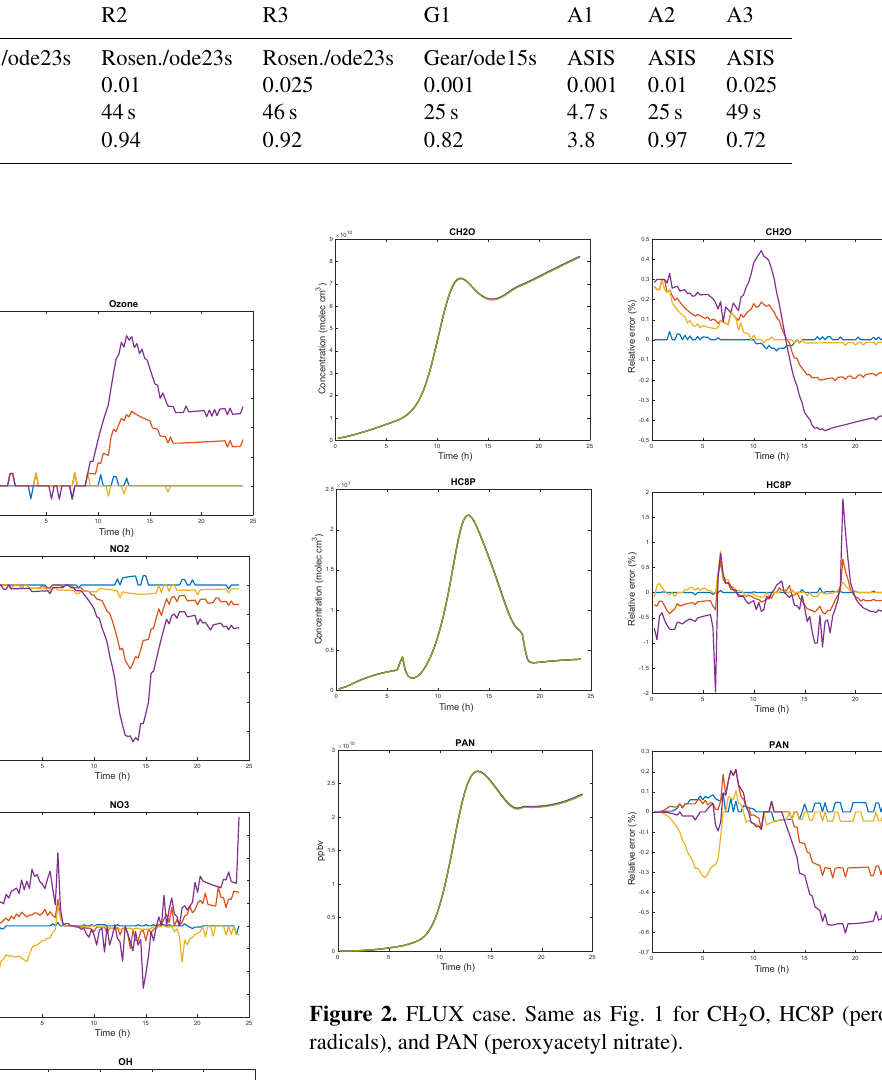
Table 4. List of the different settings used by the 0-D model for the FLUX test case. The mean time step is denoted by δt m and CPU-Ratio is the CPU time used in each simulation relative to R1. The simulations are performed in the MATLAB environment. R1